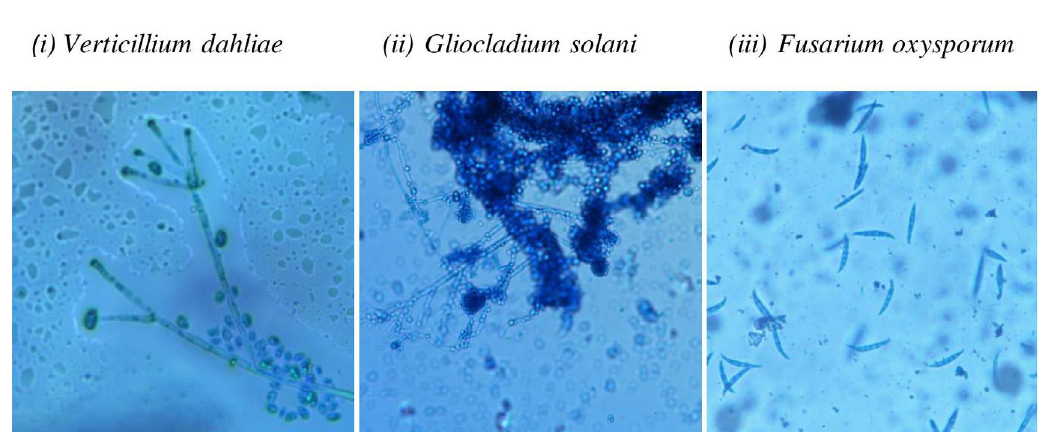
Fig. 3. Photomicrographs of endophytic